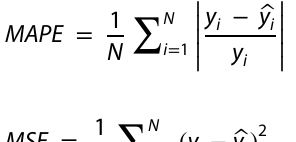
Fig. 7 Output feature of the test set